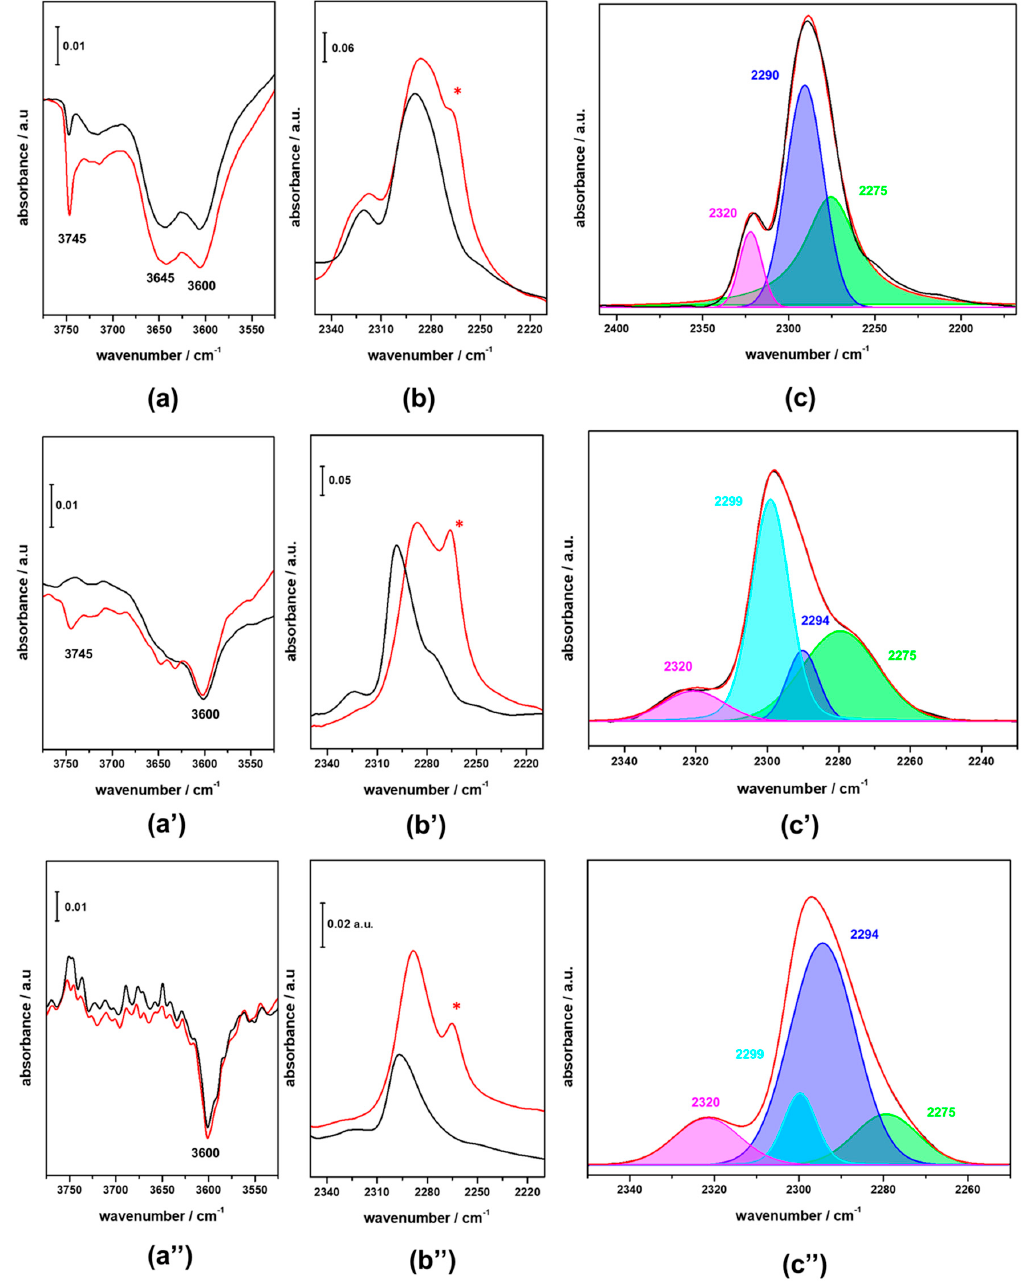
Figure 2. FTIR difference spectra of HFER catalysts at maximum d 3 -acetonitrile coverage and after desorption of the probe molecules at r.t. (red and black curves, respectively, in sections a , a’ , a” , b , b’ ,